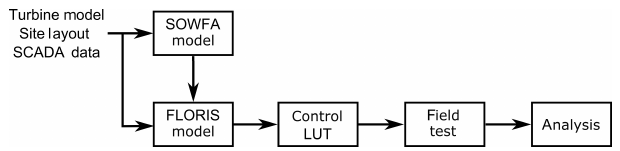
Figure 1. This figure demonstrates the workflow of this project. In particular, this project started by running CFD models of the turbines in this field study to understand the wake characteristics. The FLORIS model was tuned to those CFD simulations. A control look-up table was generated that contained the optimal yaw settings for the control turbine. A field test was conducted with the controller on and off. The data were analyzed and the results are presented in this paper. LUT – look-up table; SCADA – supervisory control and data